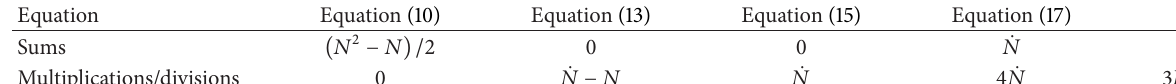
Table 1: Total computational complexity of the SS-MO technique.